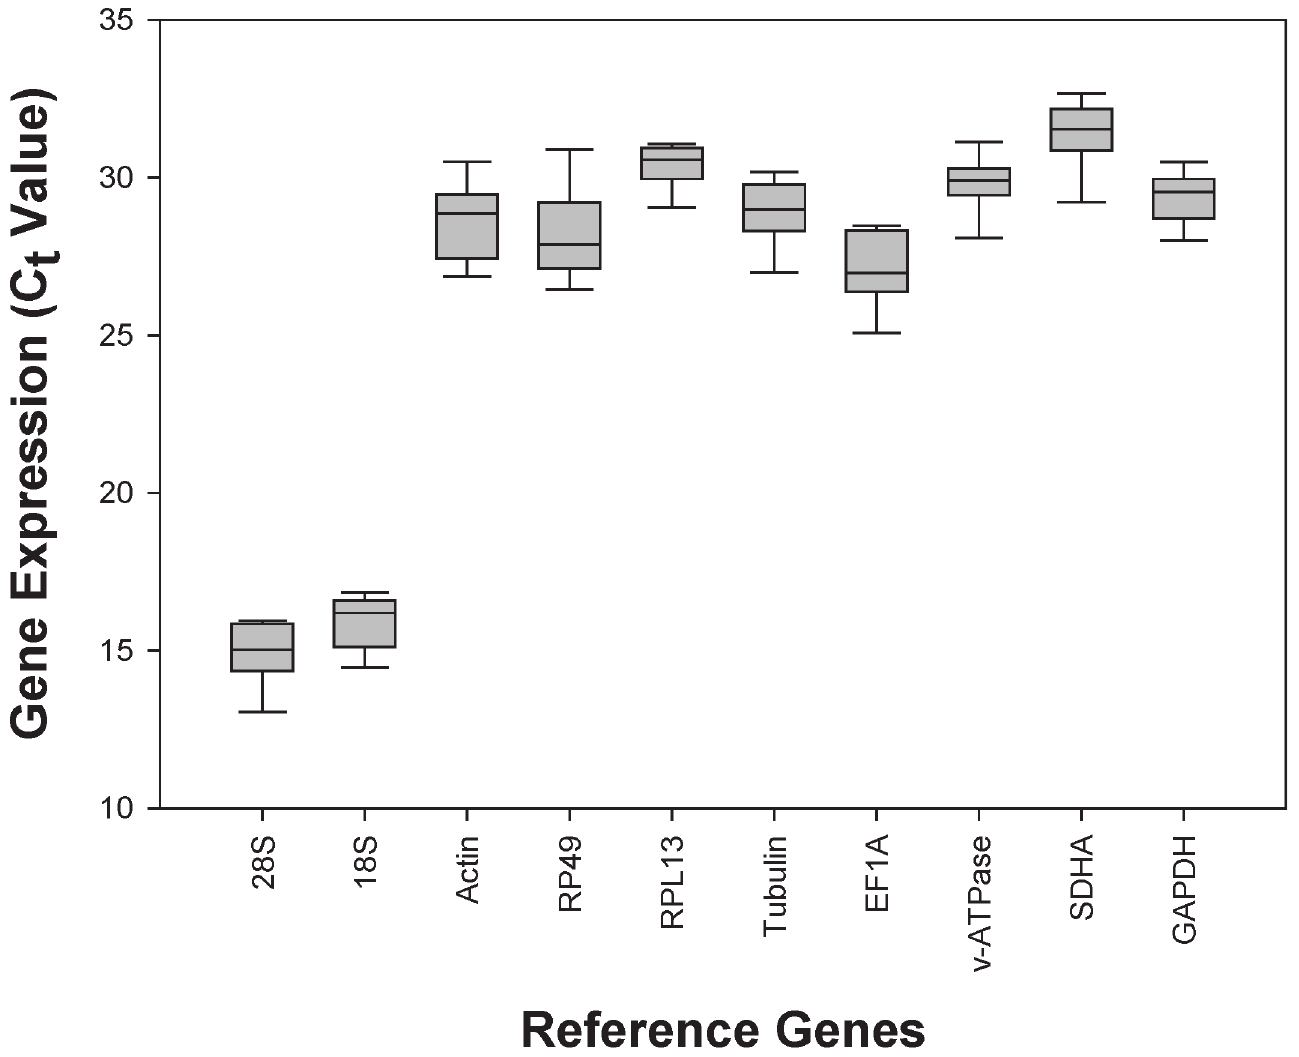
Fig 1. Expression profile of candidate reference genes in Tetranychus urticae . The expression of candidate reference genes was documented in C t - value. The median is represented by the line in the box. The interquartile rang is bordered by the upper and lower edges, which indicate the 75 th and 25 th percentiles,